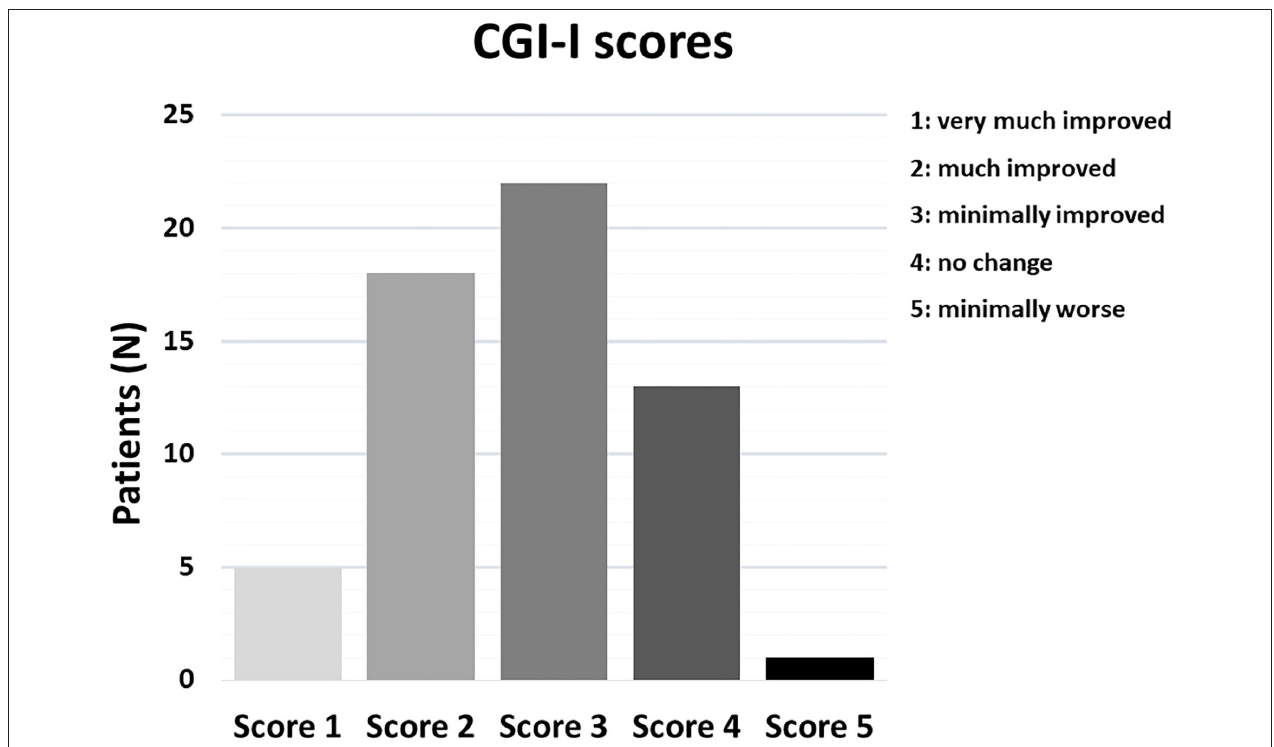
FIGURE 2 | Distribution of CGI-I clinical improvement scores.